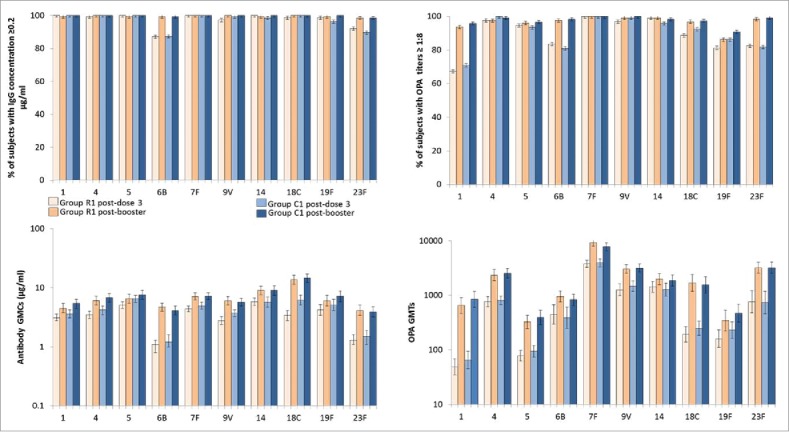
Anti-pneumococcal antibody concentrations and OPA titers after primary vaccination with PHiD-CV (with or without RTS,S/AS01 co-administration) and booster vaccination (according to protocol immunogenicity cohort at each time point). Vertical lines indicate 95% confidence intervals, OPA = opsonophagocytic activity, PHiD-CV = 10-valent pneumococcal non-typeable Haemophilus influenzae protein D conjugate vaccine, GMC/T = geometric mean antibody concentration/titer.